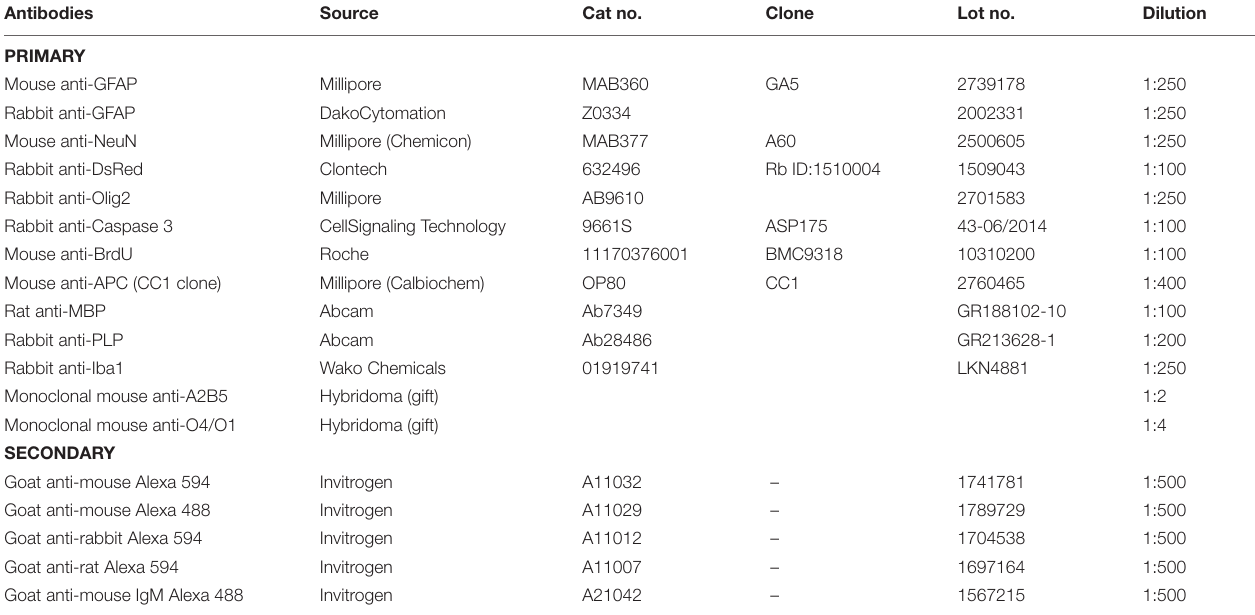
TABLE 1 | Clone, source, and dilution of antibodies. Antibodies Source Cat no. Clone Lot no.